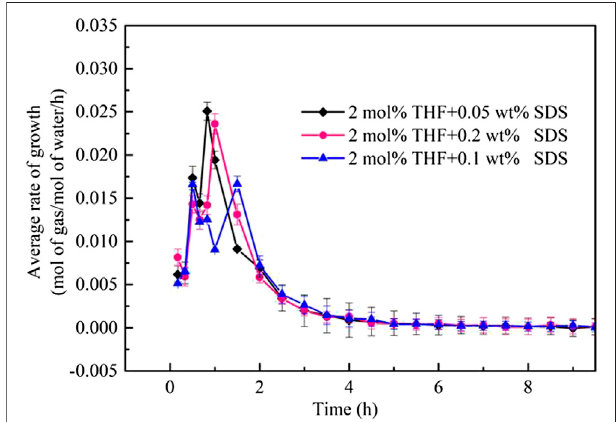
FIGURE 8 | Rate of CO 2 hydrate formation at different initial molar concentrations of 2 mol% THF + 0.10 wt% SDS.